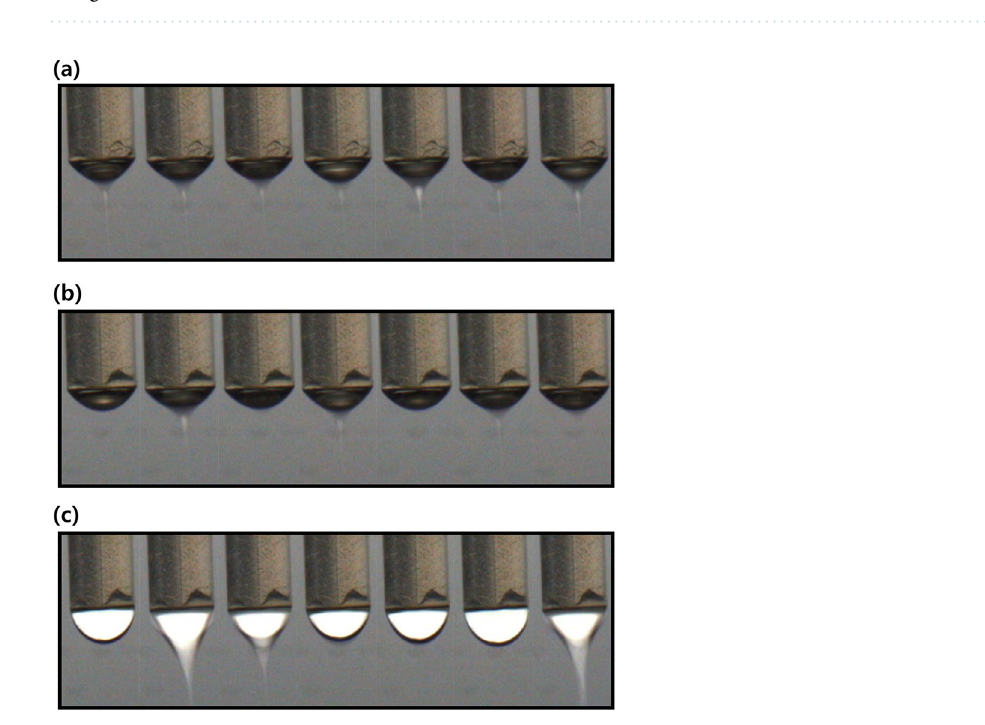
were located within that range. Considering that the cone-jet mode can be divided into more specific modes of tilted-jet, twin-jet, and multi-jet, the utilization of a wider range of frequency data would facilitate discrimina- tion of such diverse electrospray modes. As this study represents the first attempt at mode discrimination using electric current and CNN, we focused on the discrimination among the three modes of the electrospray process. The collected frequency data exhibited slight data imbalance originated from the narrow processing window of